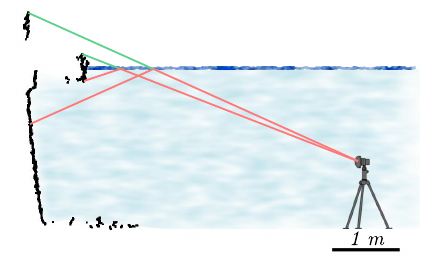
Figure 9. Signal reflection on the water surface may cause artifacts.